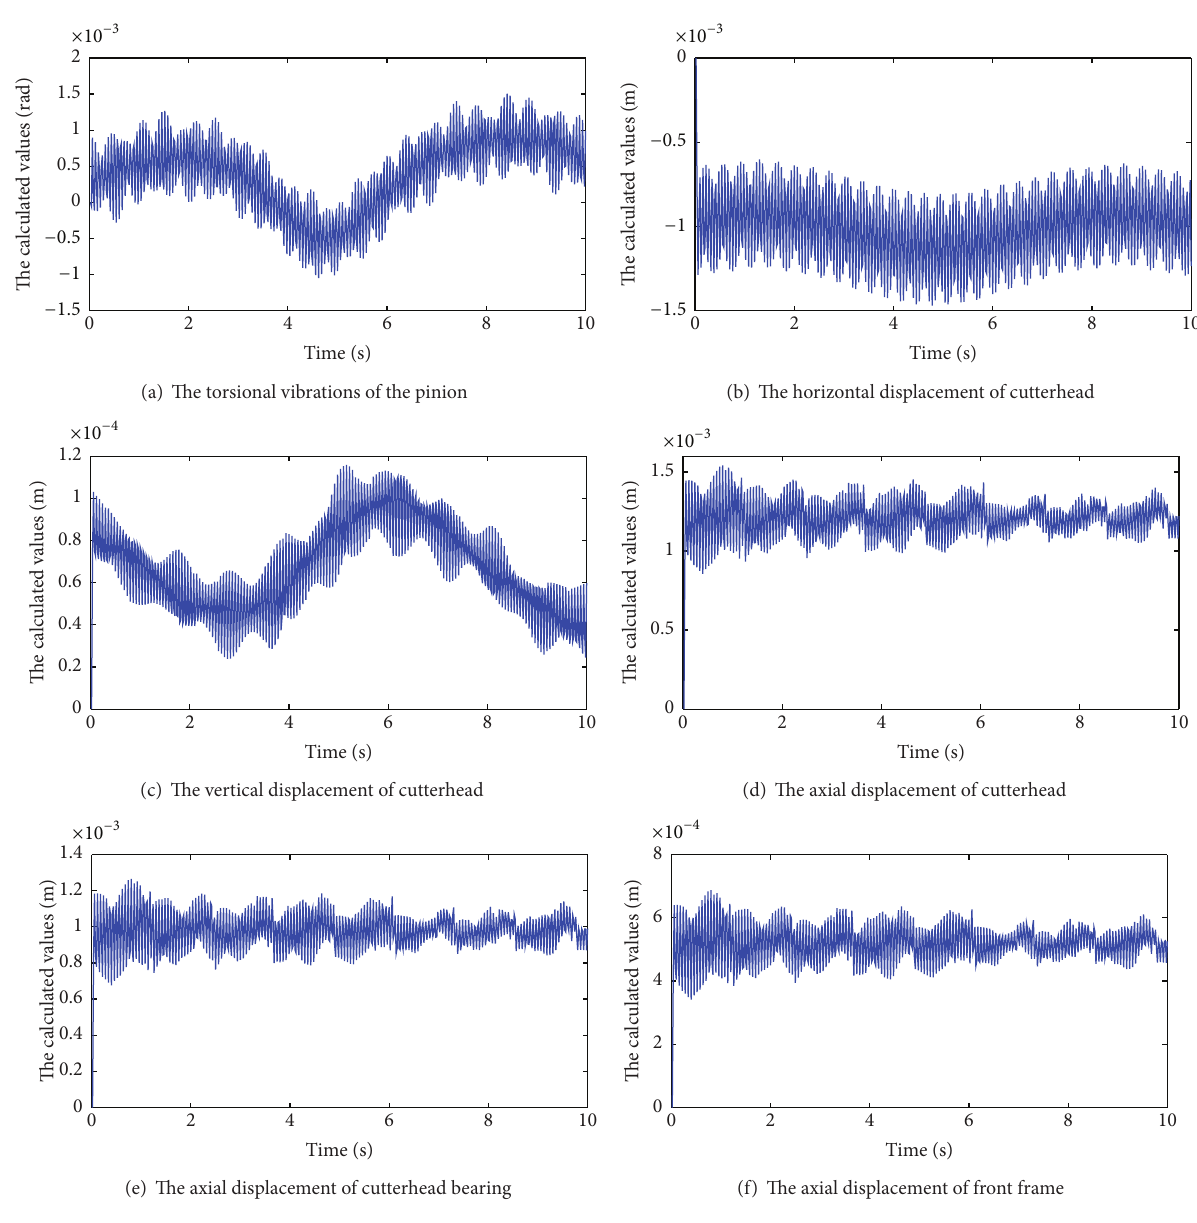
Figure 5: The response curve of each